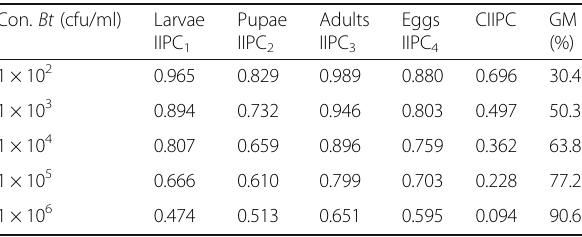
Table 1 Effect of different concentrations of Bt CAB109 Con. Bt